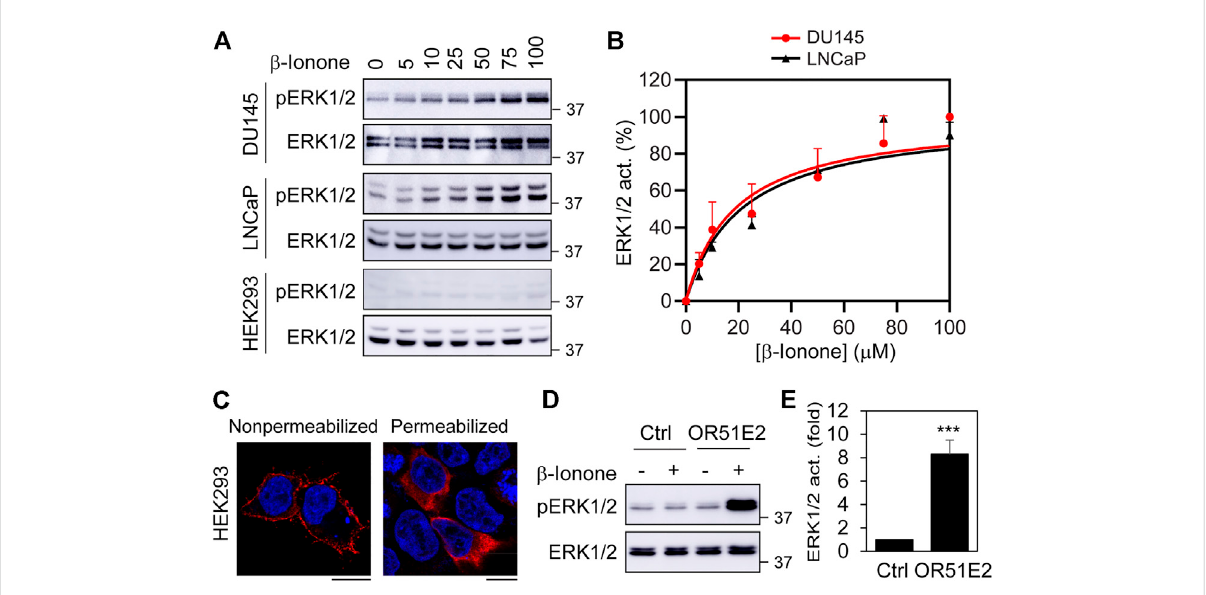
FIGURE 1 ERK1/2 activation by ectopically expressed OR51E2 in DU145, LNCaP and HEK293 cells. (A) ERK1/2 activation by β -Ionone. The cells were cultured on 6-well dishes, starved for 24 h (HEK293 cells) or 48 h (DU145 and LNCaP cells), and then stimulated with different concentrations of β - ionone for 5 min. (B) Quantitative data shown in A. (C) Subcellular distribution of FLAG-OR51E2 in HEK293 cells revealed by confocal microscopy. HEK293 cells were transfected with FLAG-tagged OR51E2 for 24 h and stained with FLAG antibodies with (right panel) or without (left panel) permeablizationwithTritonX-100for5 min.Theimagesshownarerepresentativesofthreeexperiments.Scalebars:10 μ m. (D) ERK1/2activationby β -ionone in HEK293 cells expressing exogenous OR51E2. HEK293 cells were transfected with OR51E2 for 24 h and stimulated with β -ionone at 100 μ M for 5 min after starvation for 24 h. (E) Quantitative data shown in D. The quantitative data are presented as means ± SE ( n = 3). *** p < 0.001 versus